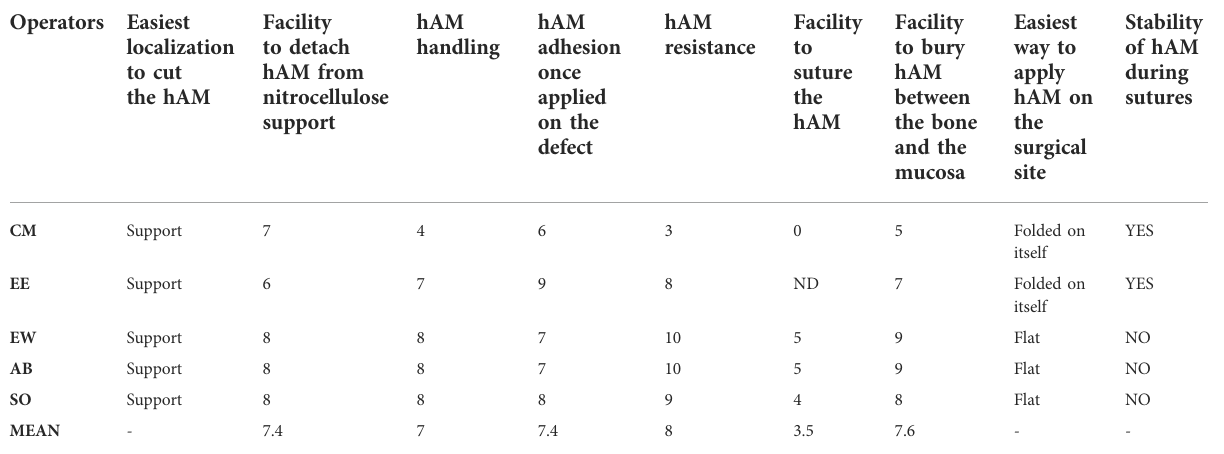
TABLE 1 Evaluation by the surgeons. ND: not done. Operators Easiest